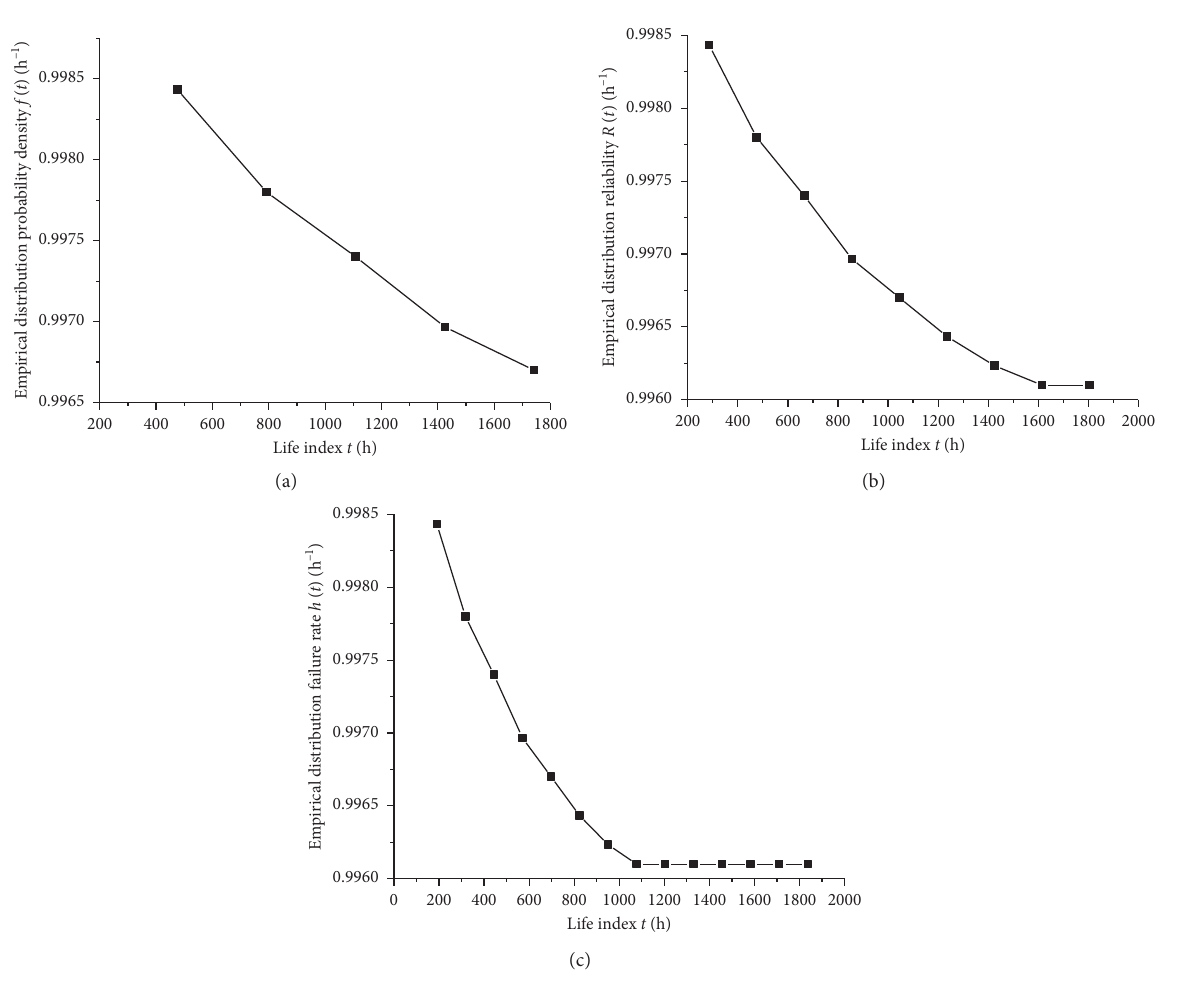
Figure 7: Reliability changes with Δ t . (a) Δ t � 316 . 55 ( n � 6). (b) Δ t � 189 . 93 ( n � 10). (c) Δ t � 126 . 62 ( n �